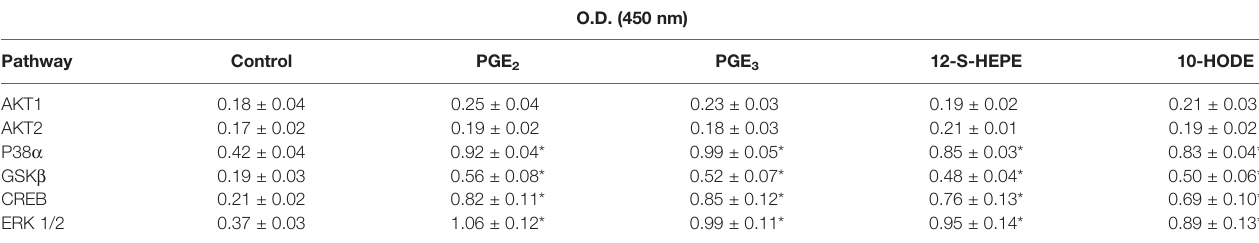
TABLE 2 | Effect of eicosanoids (PGE 3 and 12-S-HEPE) and 10-HODE on cell signaling.